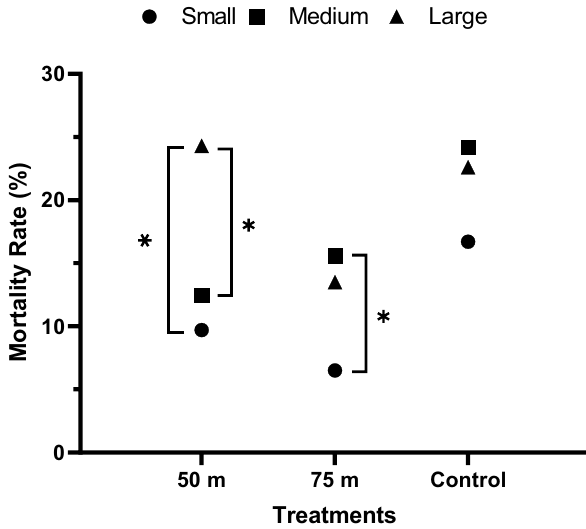
Figure 6. Effect of distance and size on mortality of malathion on monarch ( D. plexippus ) caterpillars. Mortality was assessed over 5 days on small (N = 87), medium (N = 80) and large (N = 82) caterpillars that fed on host plant leaves treated with malathion at 50 and 75 m distances from a truck-mounted sprayer applying a malathion ULV spray at the maximum label rate. Asterisks indicate significant differences between groups ( p < 0.05), using GLM with the Poisson